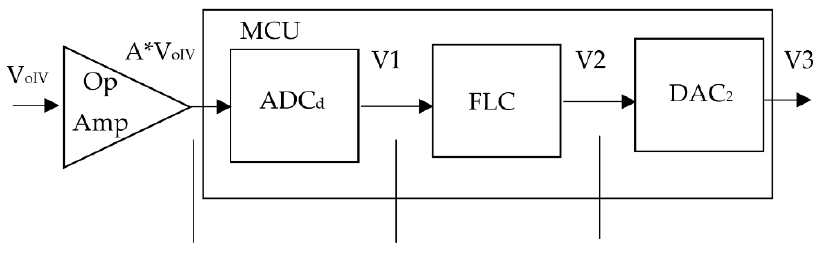
Figure 7. Measurement circuit of AGC based on an MCU processor [29].